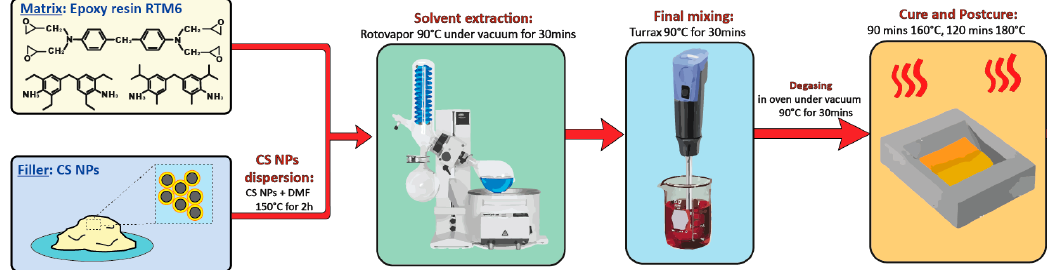
Figure 2. The manufacturing procedure of CSNPs/RTM6 nanocomposites.